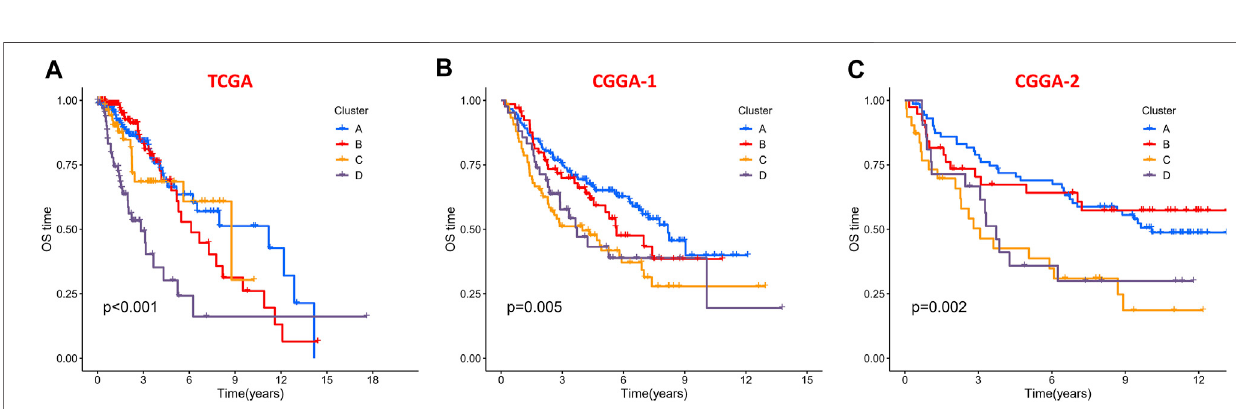
Frontiers in Genetics |